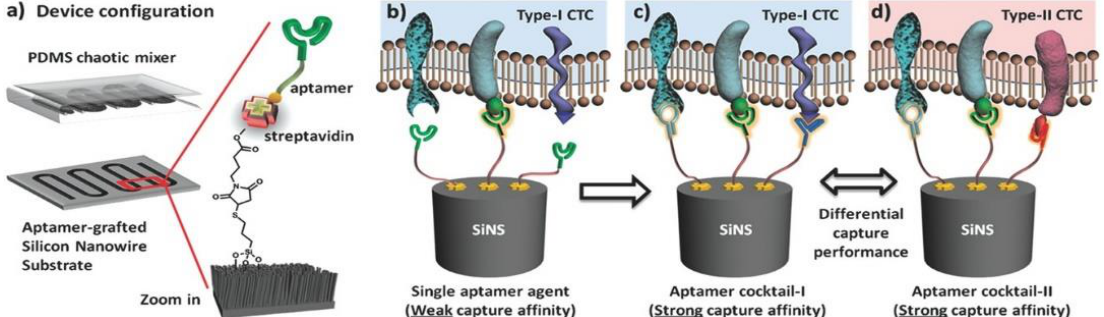
Figure 3. Schematic description of aptamer-cocktail-based microfluidic approach for CTC detection.